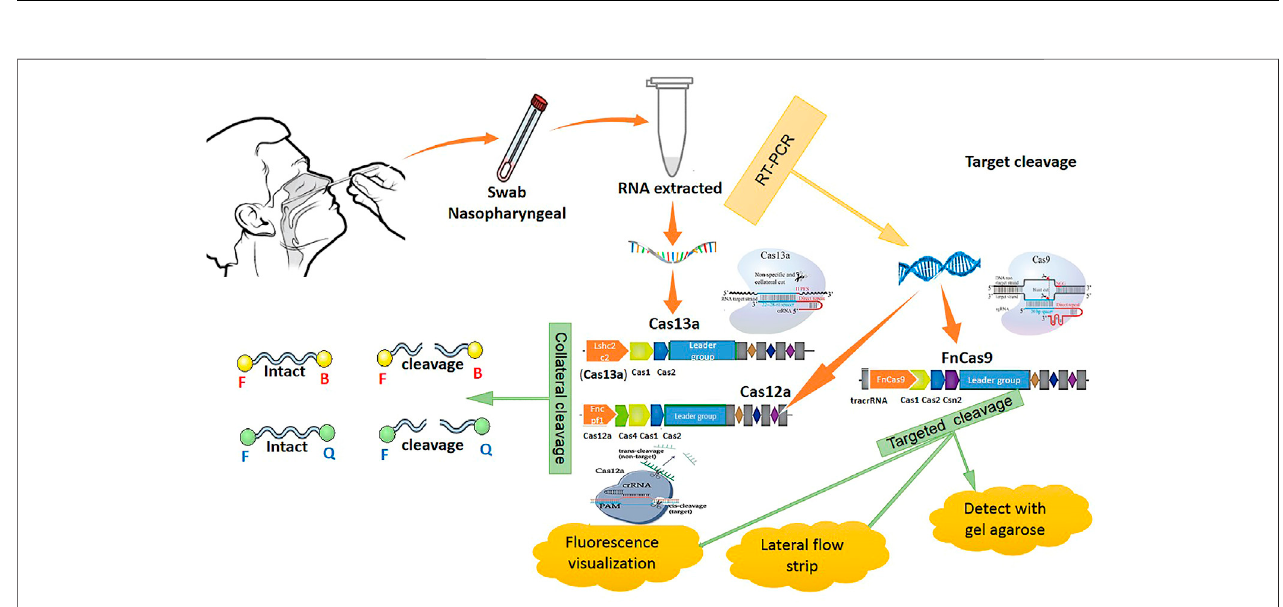
FIGURE 3 | CRISPR methods for COVID-19